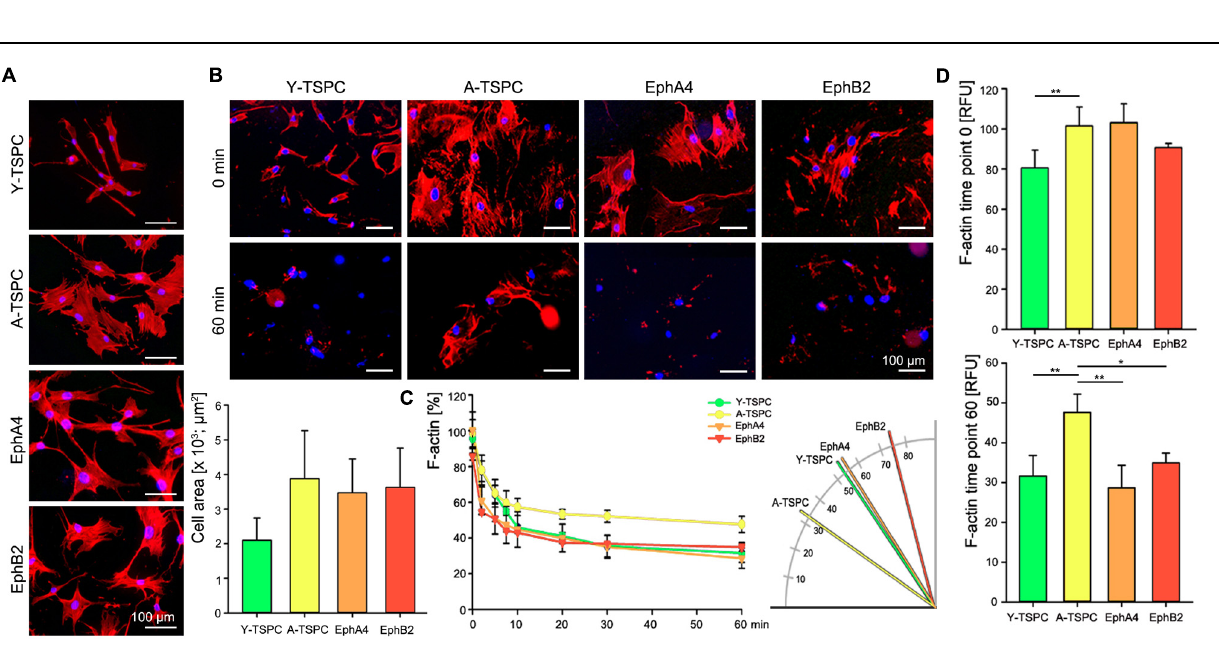
Frontiers in Aging Neuroscience |